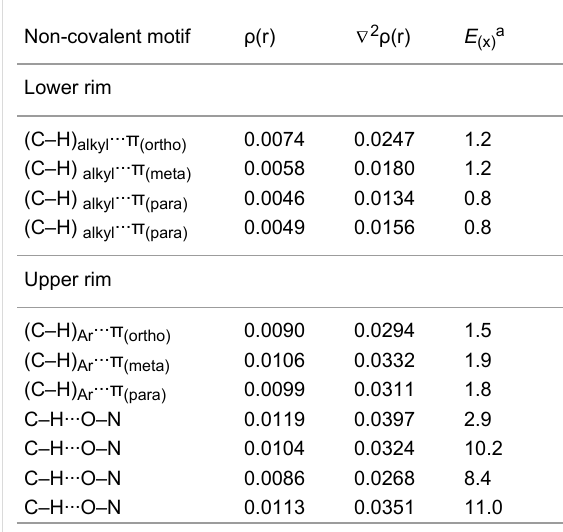
Table 2: Values of the density of all electrons ρ (r) and Laplacian of electron density – 2 ρ (r), (Hartree) at the bond critical points (3, − 1) for selected significant lower-rim non-covalent C–H··· π and H-bond C–H···O–N as well as upper-rim endo cavity C–H··· π interactions in the model system 3 @BrC6 as well as calculated energies of these bonds, E (x) (kcal/mol), proposed by Espinosa et al.